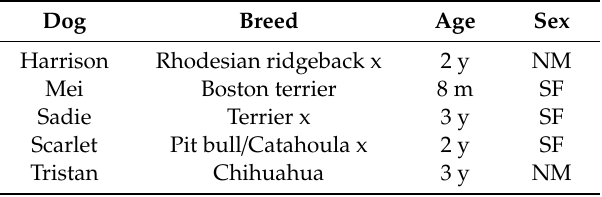
Table 1. Dog Demographics. Breeds are based on owner reports. Ages are reported in months (m) and years (y). Sex is indicated by M (male) or F (female). N indicates the dog is neutered and S indicates the dog is